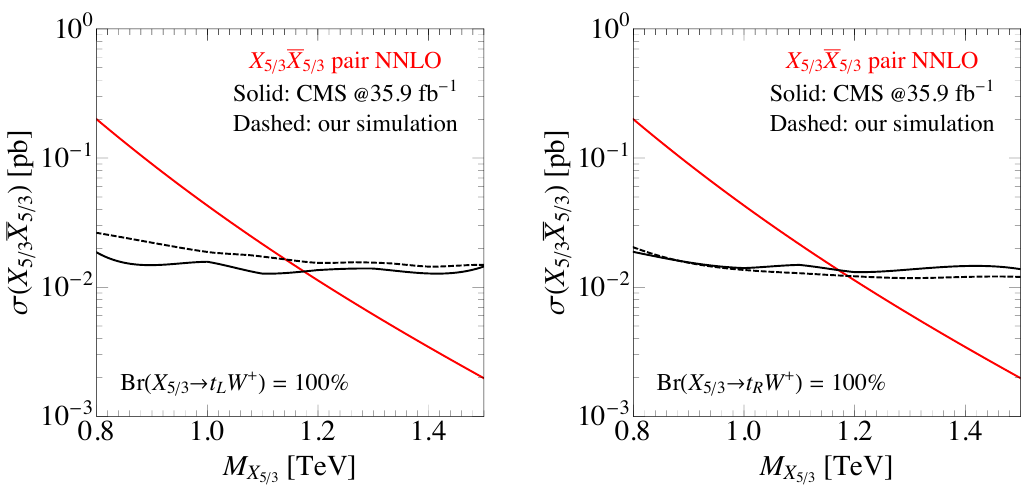
Figure 1 . Expected bound on the QCD X pair production cross-section from our recast (dashed) 5 = 3 compared to the CMS results [10] (solid) for left-handed (left) and right-handed (right) couplings. In red we show the X pair production cross section at 5 = 3